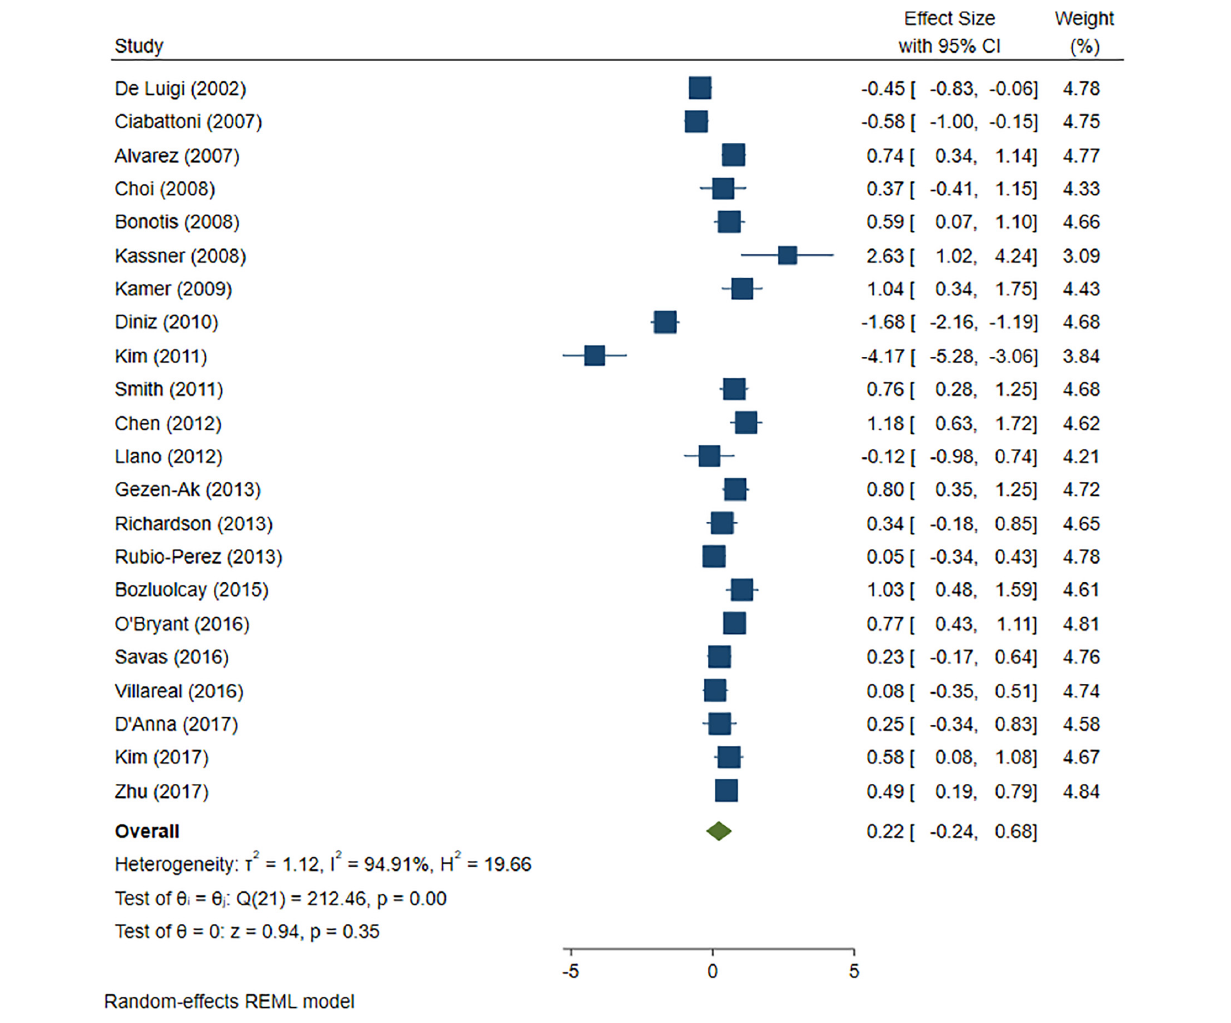
FIGURE5 Forest plot of pooled Hedge’s g depicting high tumor necrosis factor (TNF)-alpha concentration in Alzheimer’s disease (AD) samples compared to controls.